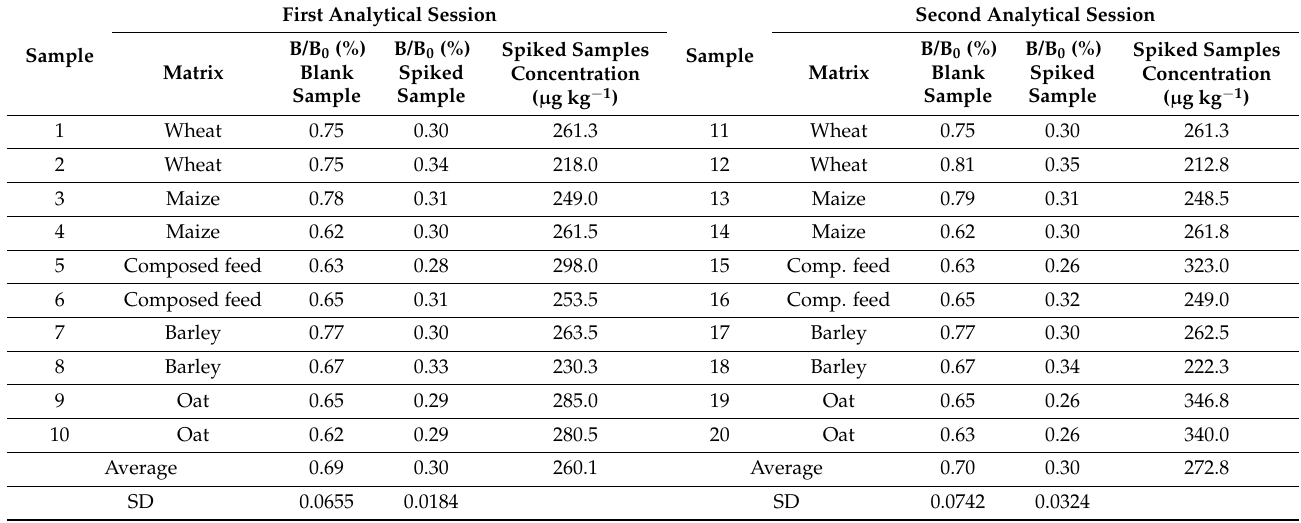
Table 2. Selectivity tests of ELISA validation. Results obtained by analyzing 20 cereal blank samples and samples spiked with 250 µ g kg − 1 of the HT-2